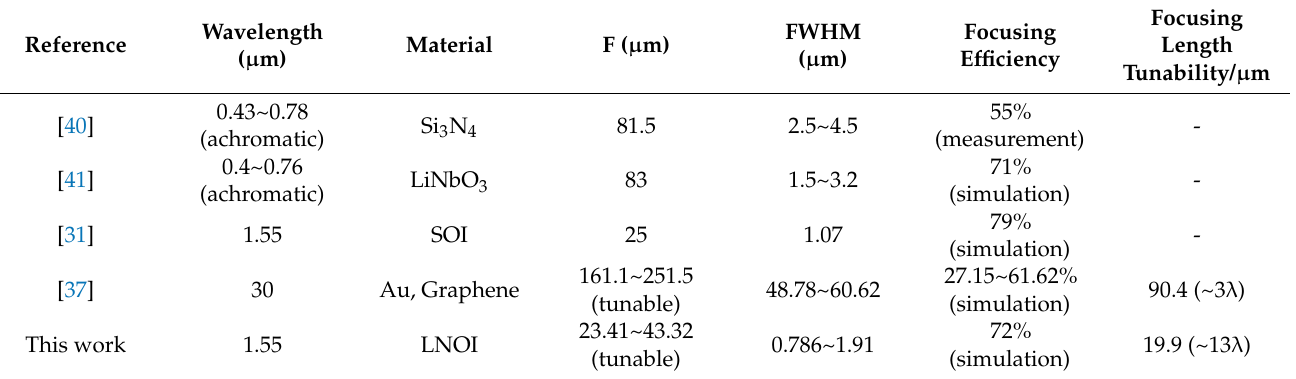
Table 1. Summary of performance metrics for metalenses.